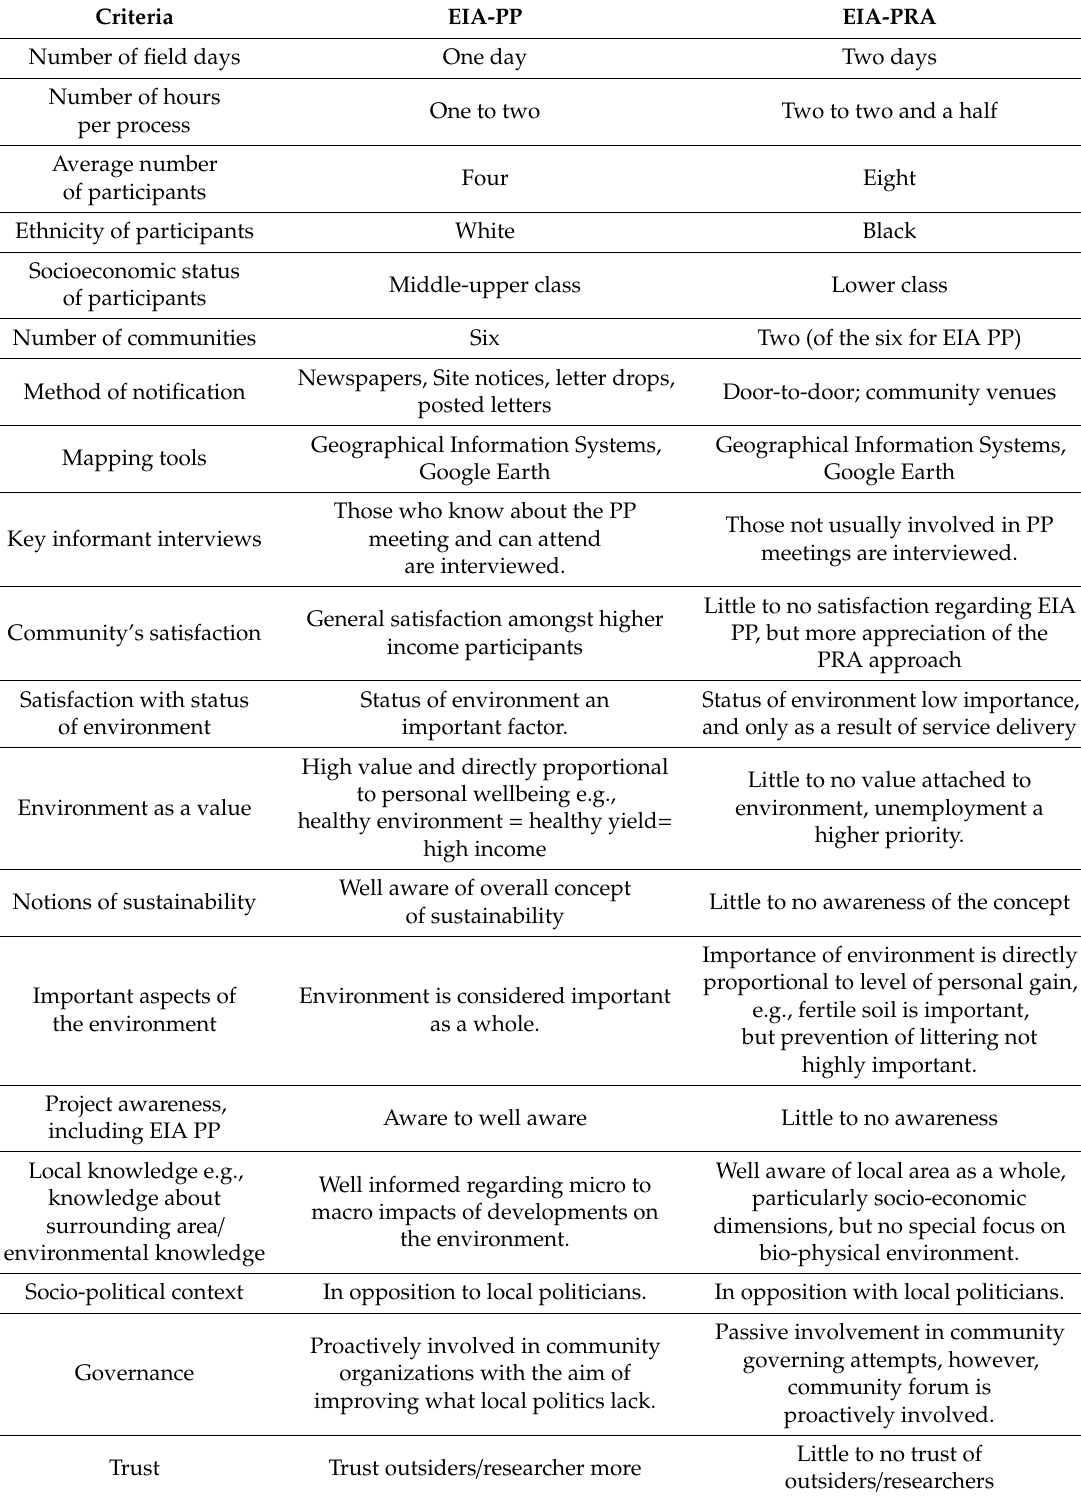
Table 1. Similarities and di ff erences between the public participation (PP) and participatory rural appraisal (PRA) processes for environmental impact assessment (EIA) of six photovoltaic farms in South